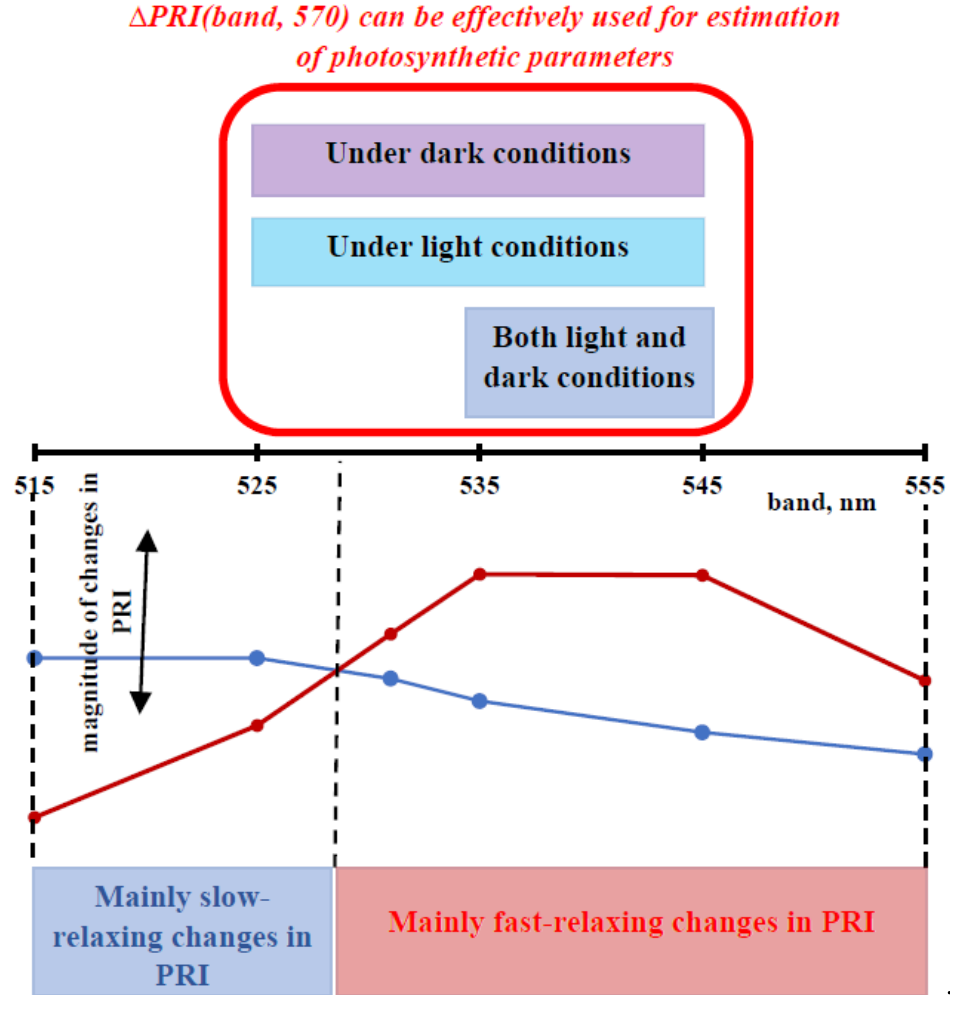
Figure 9. The hypothetical schema of the effective use of the ∆ PRIs ( ∆ PRI(band,570)), calculated on the basis of the intensities of the reflected light at different wavelengths (band), for the estimation of the photosynthetic parameters at different variants of analysis (values under light conditions, under dark conditions, or under a combination of light and dark conditions). The figure also shows the fast- and slow-relaxing components in the ∆ PRIs.